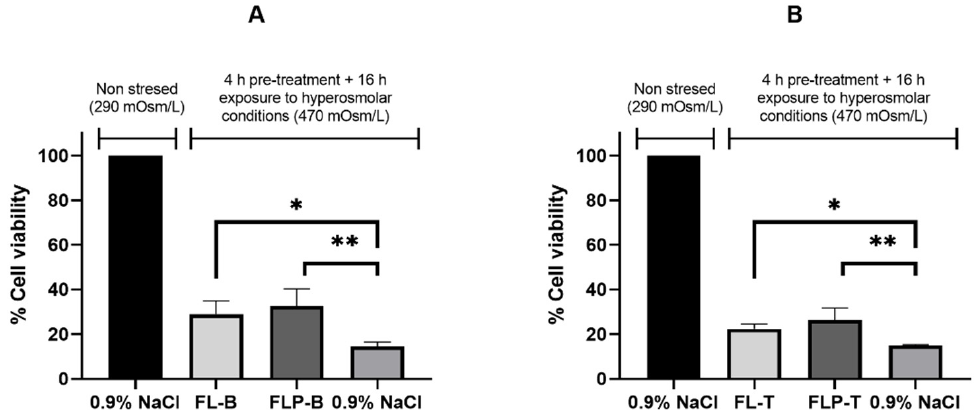
Figure 4. Osmoprotective effect after liposomes pre-incubation during 4 h and exposure to a 470 mOsm/L NaCl solution during 16 h. Evaluation of liposomal formulations containing brimonidine ( A ) or travoprost ( B ) in hTERT-HCECs cells (* p < 0.05; ** p < 0.005).